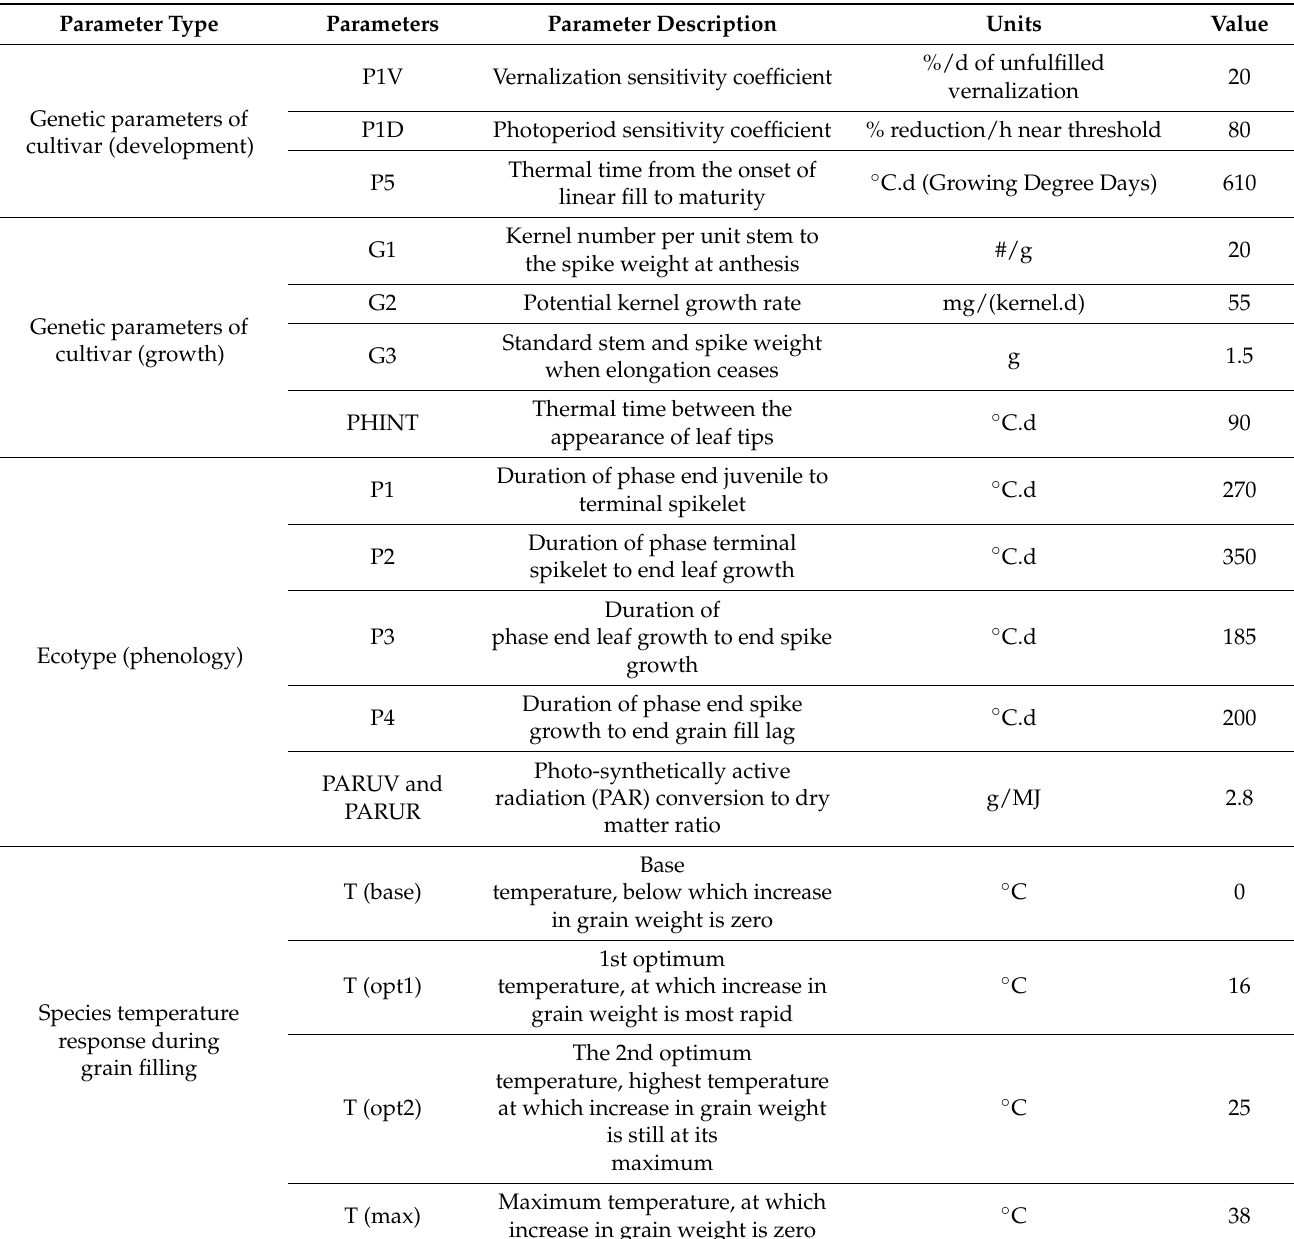
Table 5. Cultivar (PBW-343)-specific critical parameters and values after sensitivity analysis and